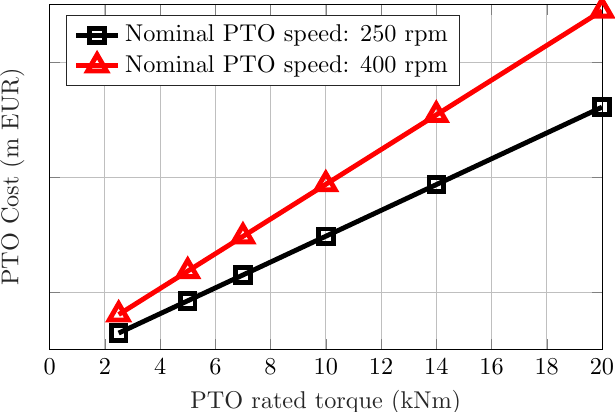
Figure 8. Cost of each power take-off, linearly proportional to the rated torque, with slope depending on the nominal speed. Table 1. Thirteen design parameters used by the genetic algorithm to univocally define an individual, as discussed in Section 3.1. Discrete values with constant spacing are used, with lower and upper bounds. Design